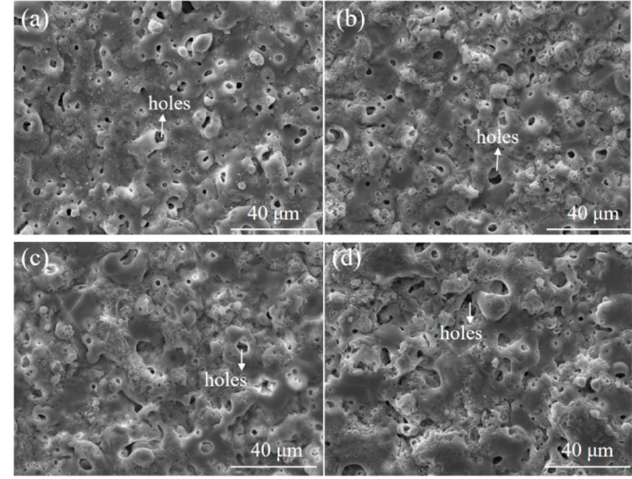
Figure 5. The thickness increasing of layers on different Al-12 Si during different MAO periods.